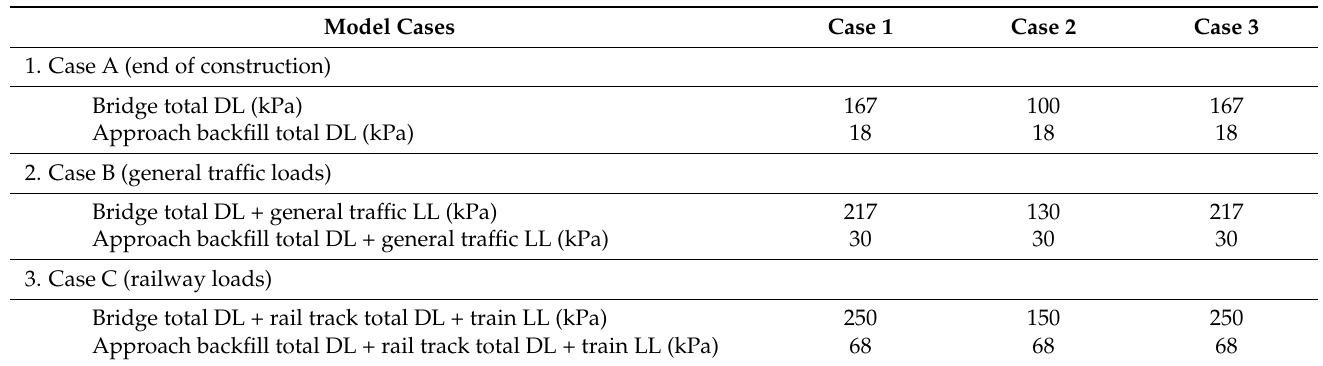
Table 3. Static loading condition for each model